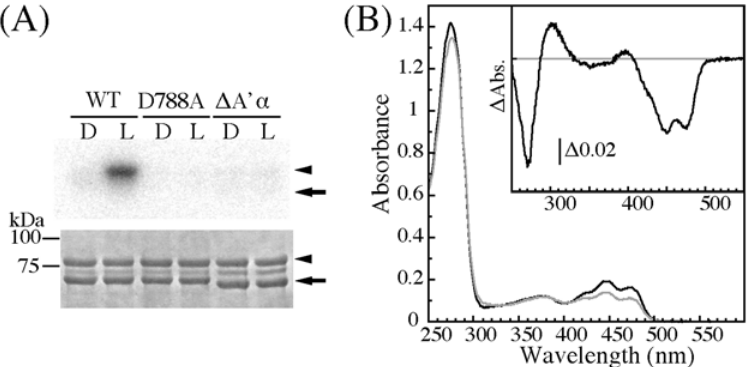
Fig 2. (A) Kinase activity of WT, D788A, and Δ A ’ α of At phot1 LOV2-STK on P1Nt in the dark (D) or under BL irradiation (L). The upper and lower panels indicate autoradiogram and CBB staining of SDS-PAGE gels, respectively. The arrow and the arrowhead indicate the position of LOV2-STK and P1Nt, respectively. (B) Absorption spectra and light minus dark absorption difference spectrum (inset) of Δ A ’ α in a solution containing 20 mM Tris-HCl, pH 7.8, 500 mM NaCl, 10% (w/v) glycerol, and 1 mM Na 2 EGTA at 20°C. The black and the gray line were measured after dark adaptation and BL irradiation, respectively.